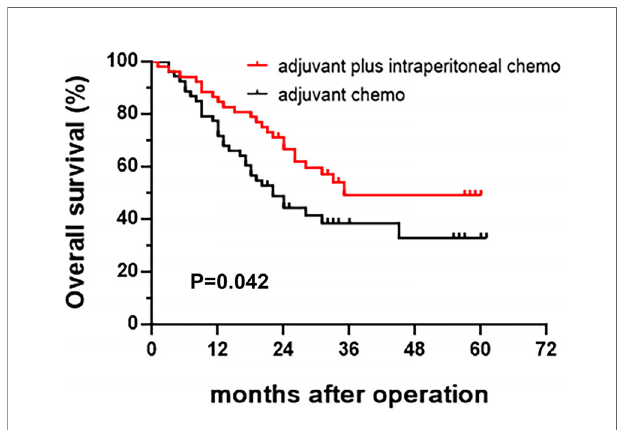
FIGURE 2 | Kaplan-Meier curve of overall survival.